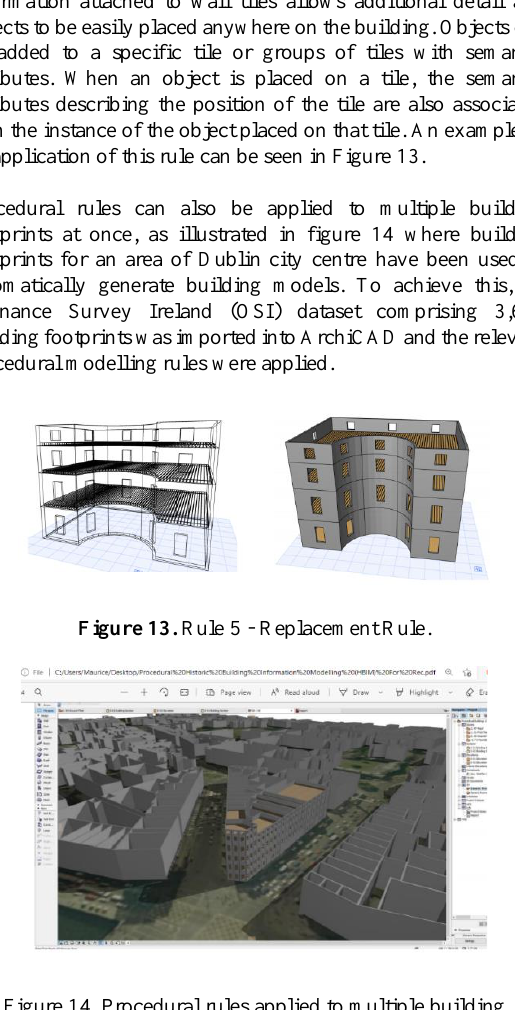
Figure 14. Procedural rules applied to multiple building